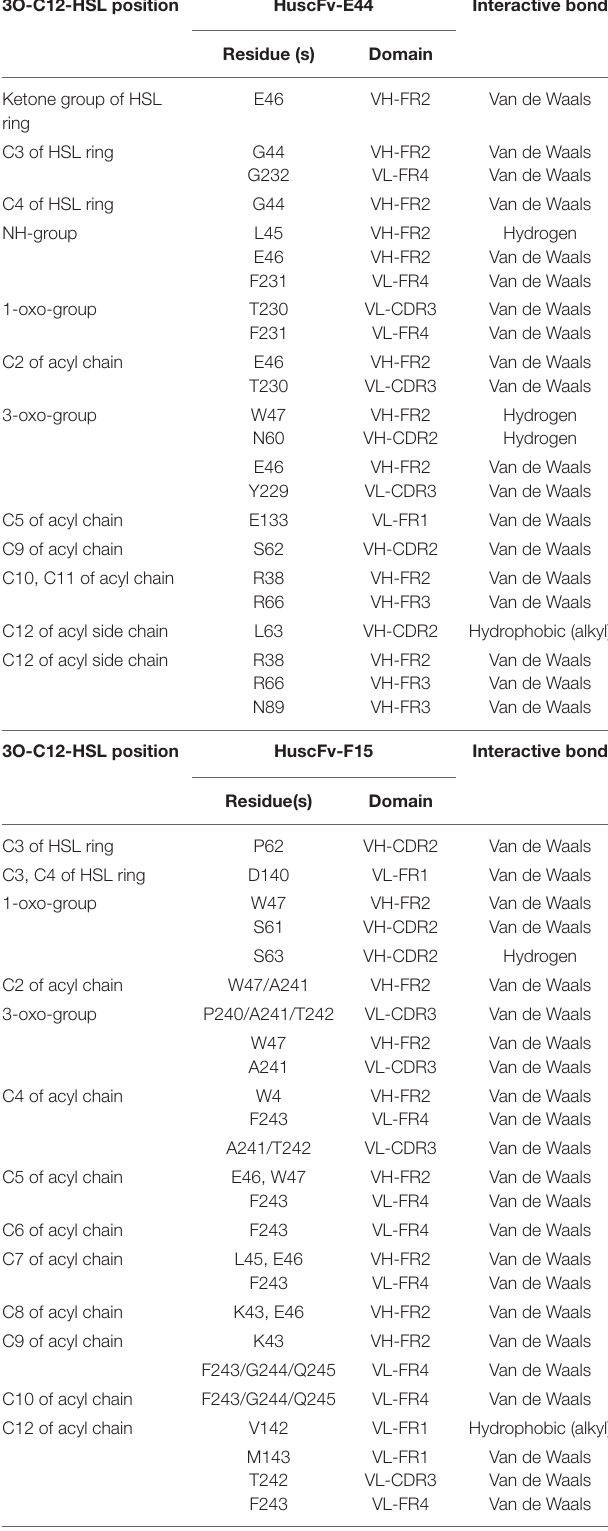
TABLE 1 | Residues of Pseudomonas aeruginosa 3O-C12-HSL predicted to form contact interfaces with the effective HuscFv-E44, HuscFv-F15, and HuscFv-F19. 3O-C12-HSL